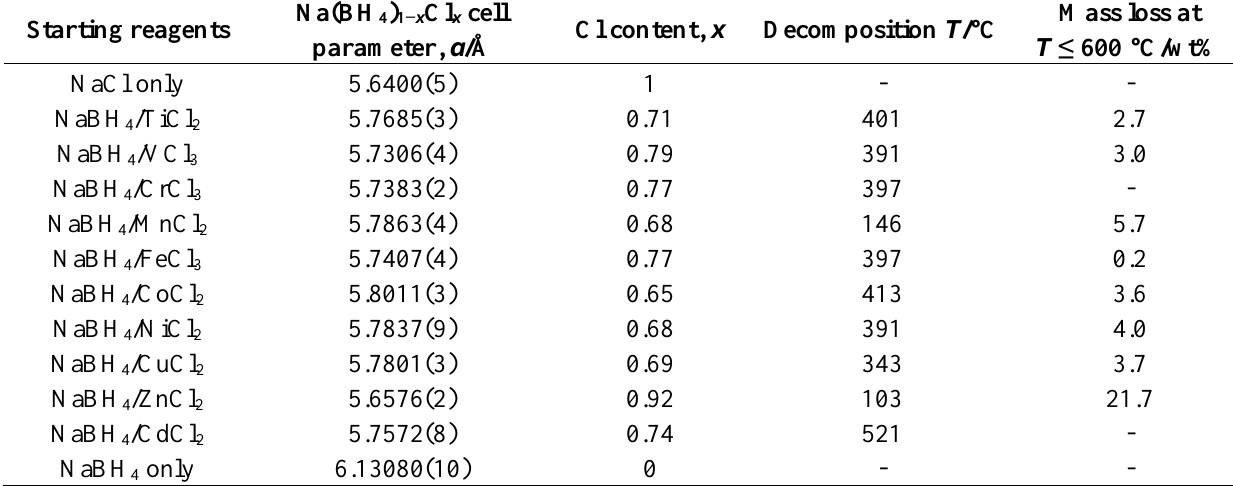
Table 2. Structural and thermal decomposition parameters for ball milled NaBH 4 + MCl n powders (mixed in in 3:1 (MCl 2 ) or 4:1 (MCl 3 ) ratios). Note: the parameters for M = Sc were not reported [75]. Reprinted from [75] with permission from Elsevier; copyright